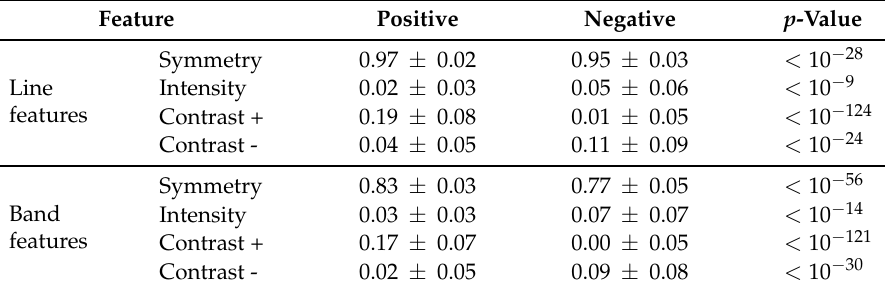
Table 2. Mean and standard deviation of features for the positive and negative lumen candidates, along with the p -value of Student’s t -test rejecting the equal distribution hypothesis.